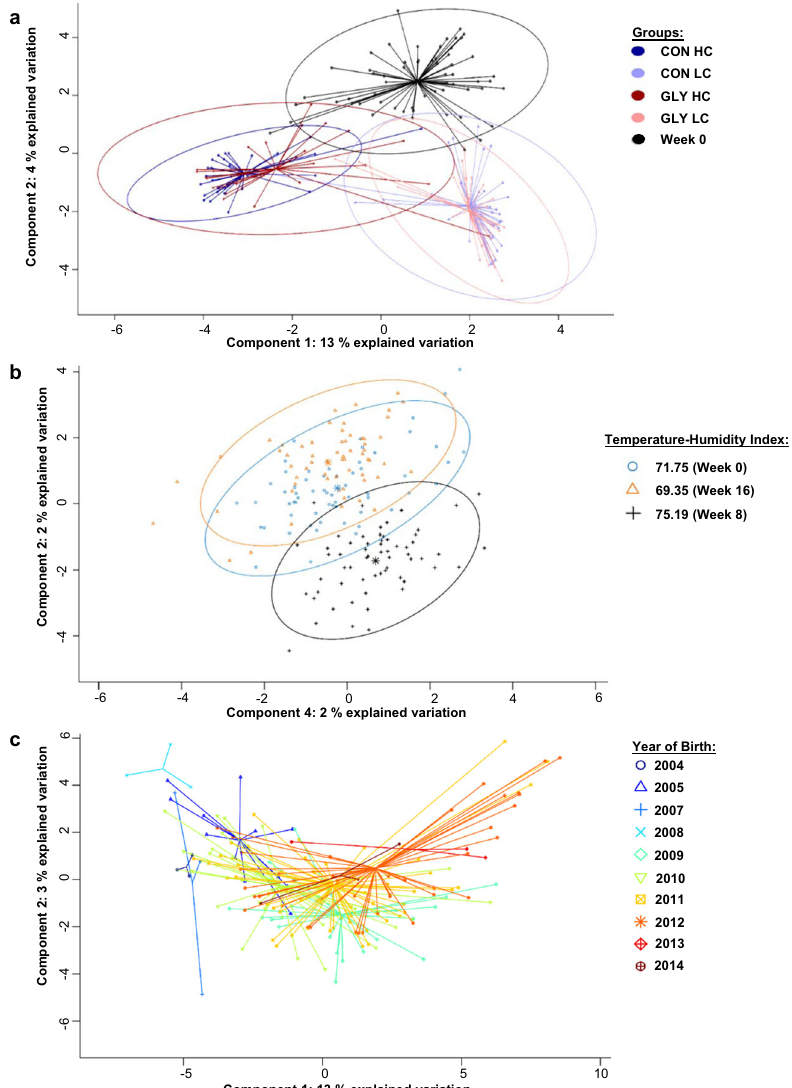
Fig. 5 Partial least squares — discriminant analyses of the ruminal microbiome in context of different discrimination factors. Results of three separate PLS-DA analyses using either concentrate feed proportion and glyphosate ( a ), the temperature-humidity-index ( b ), or the year of birth ( c ) as discrimination factors for a dataset containing the microbial taxons of the rumen microbiome. CON: groups fed with a control diet, GLY: groups fed with a glyphosate contaminated diet, CFP: concentrate feed proportion, HC: groups with a high CFP, LC: groups fed with a low